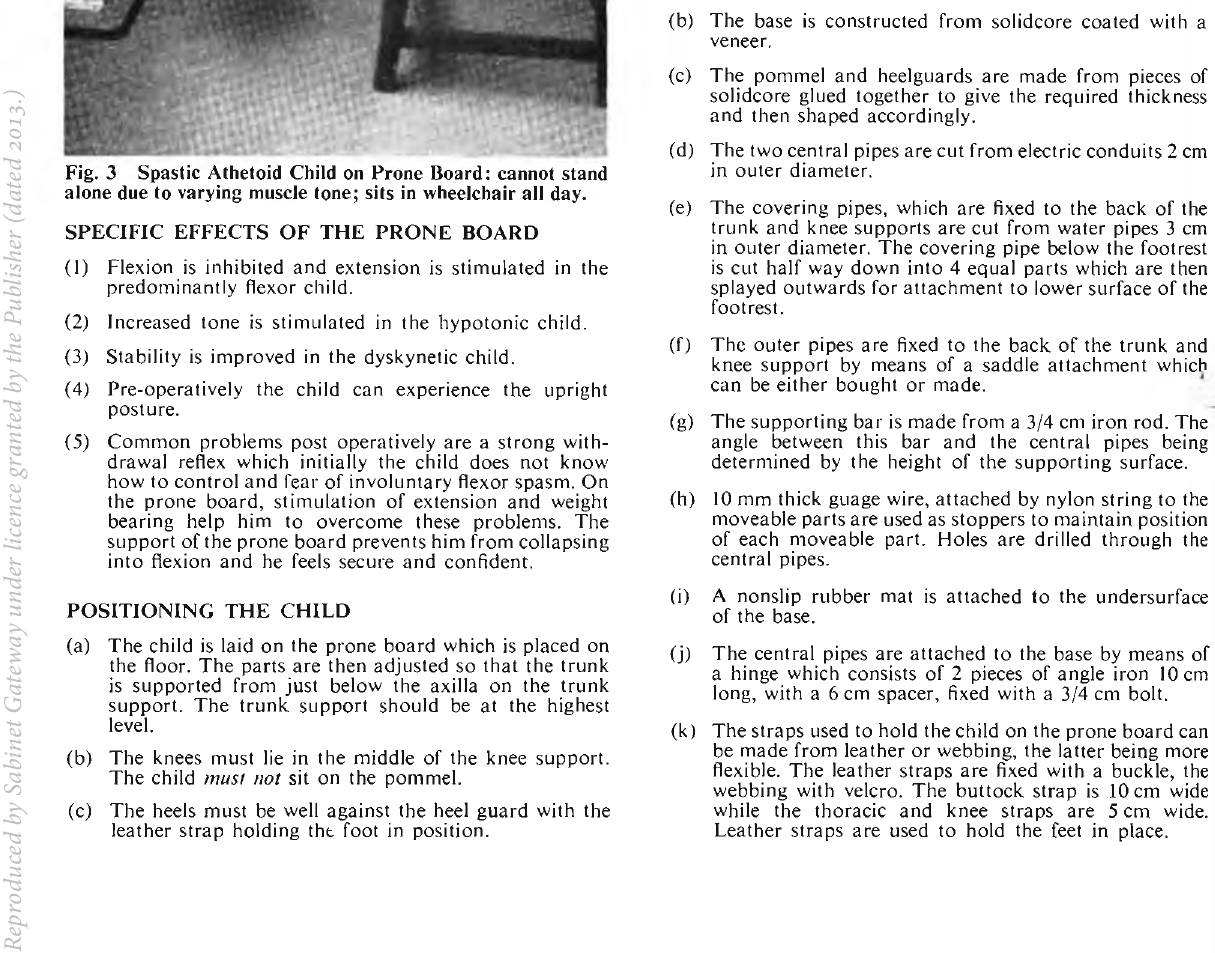
Fig. 3 Spastic Athetoid Child on Prone Board: cannot stand alone due to varying muscle tone; sits in wheelchair all day. SPECIFIC EFFECTS O F THE PRO N E